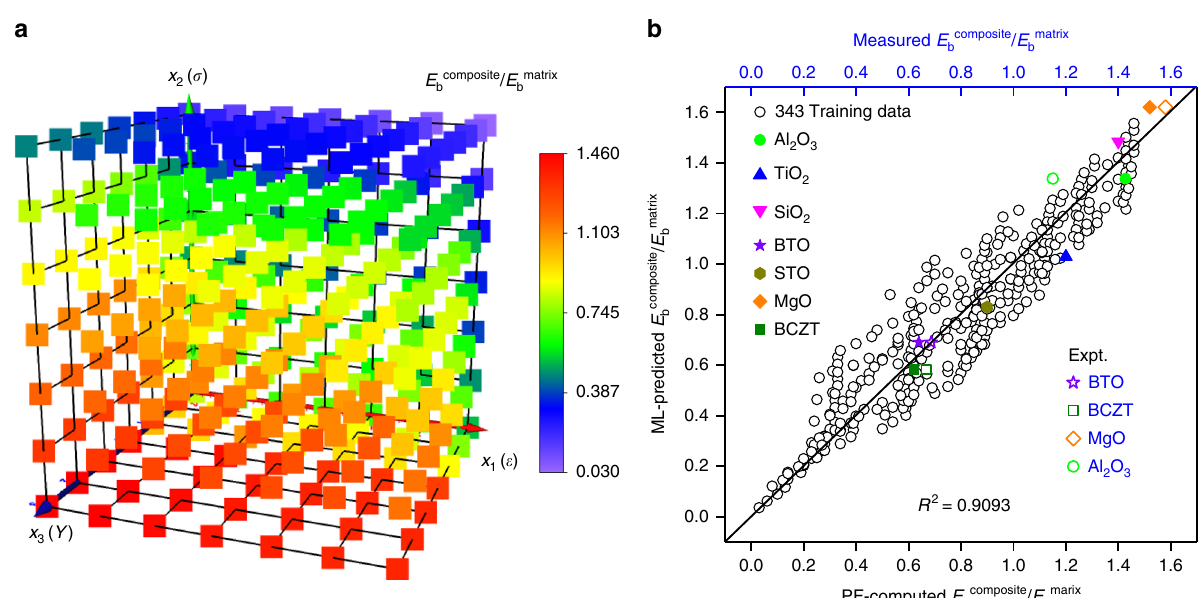
Fig. 6 High-throughput phase- fi eld simulation and machine learning results. a High-throughput simulation results of the breakdown strength for poly (vinylidene fl uoride-hexa fl uoropropylene) (P(VDF-HFP)) nanocomposites fi lled by 5 vol% nano fi llers with different dielectric constant, electrical conductivity, and Young ’ s modulus. Here, x 1 ( ε ), x 2 ( σ ), and x 3 ( Y ) represent ε fi ller / ε matrix , σ iller / σ matrix , and Y fi ller / Y matrix , respectively. b Comparisons of breakdown strengths between the phase- fi eld model and the machine learning prediction, veri fi ed by seven new types of fi llers as the testing set (not included in the training set, marked as colored solid symbols) and some experimental results (colored open symbols). The experimental measurement for the breakdown strength of Al 2 O 3 /P(VDF-HFP) nanocomposite is performed in this work. The experimental breakdown strengths for BTO/P(VDF-HFP), BCZT/P(VDF), and MgO/P(VDF) nanocomposites are from the literatures 37 –